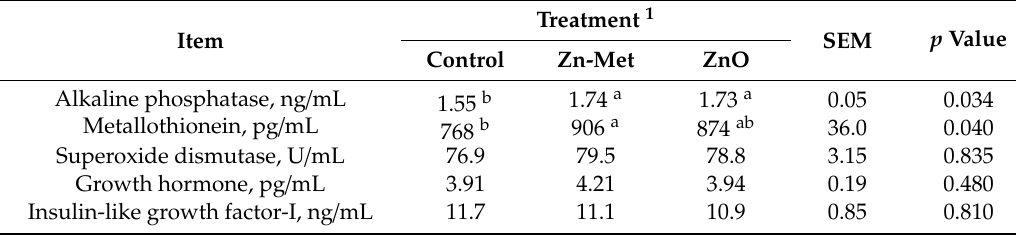
Table 5. E ff ects of Zn-Met and ZnO on the serum zinc-dependent protein concentrations of Holstein dairy